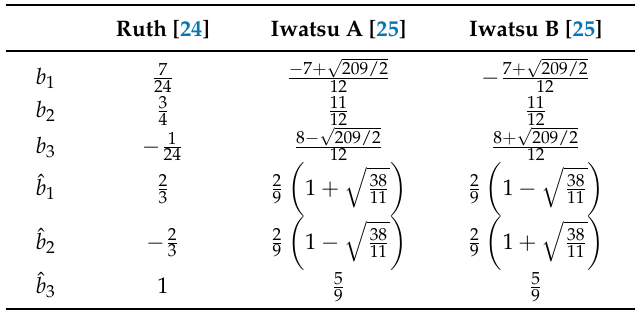
Table 1. Coefficients of the PRK3